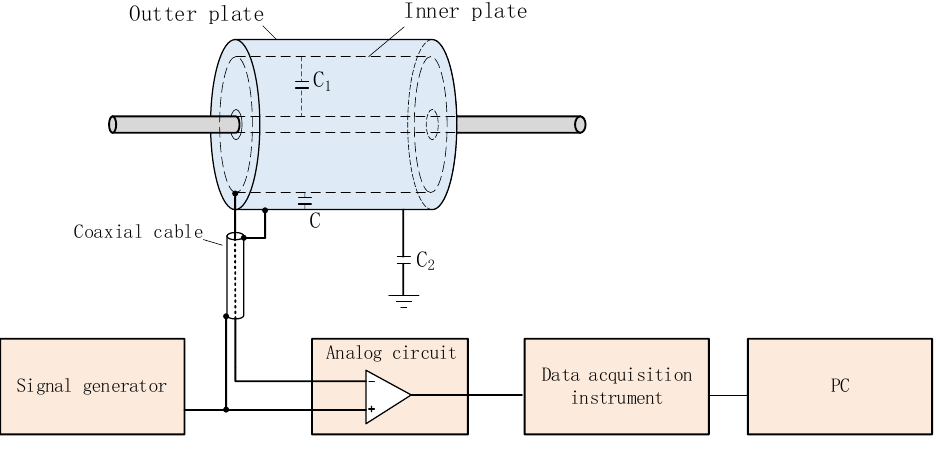
Figure 3. Voltage measurement